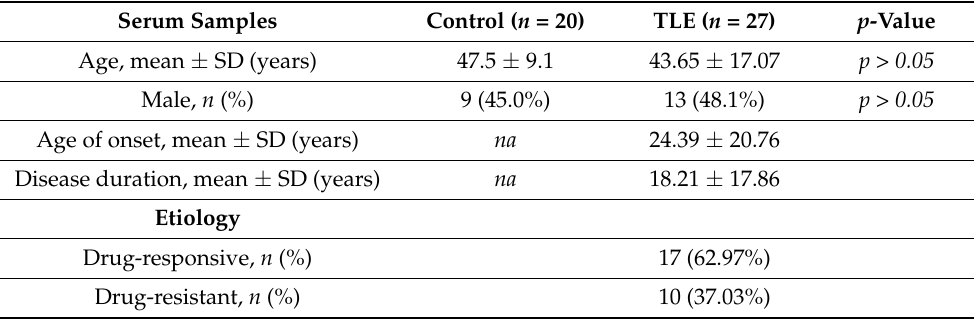
Table 2. Baseline characteristics of epilepsy patients ( na, not analyzed; t-test p-values are indicated). Serum